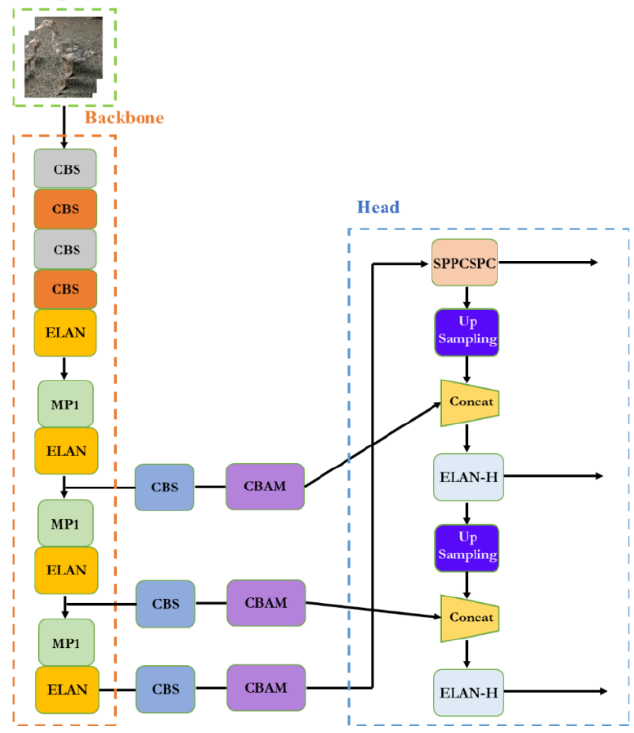
Figure 7. Addition of the YOLOv7 network structure to the CBAM.